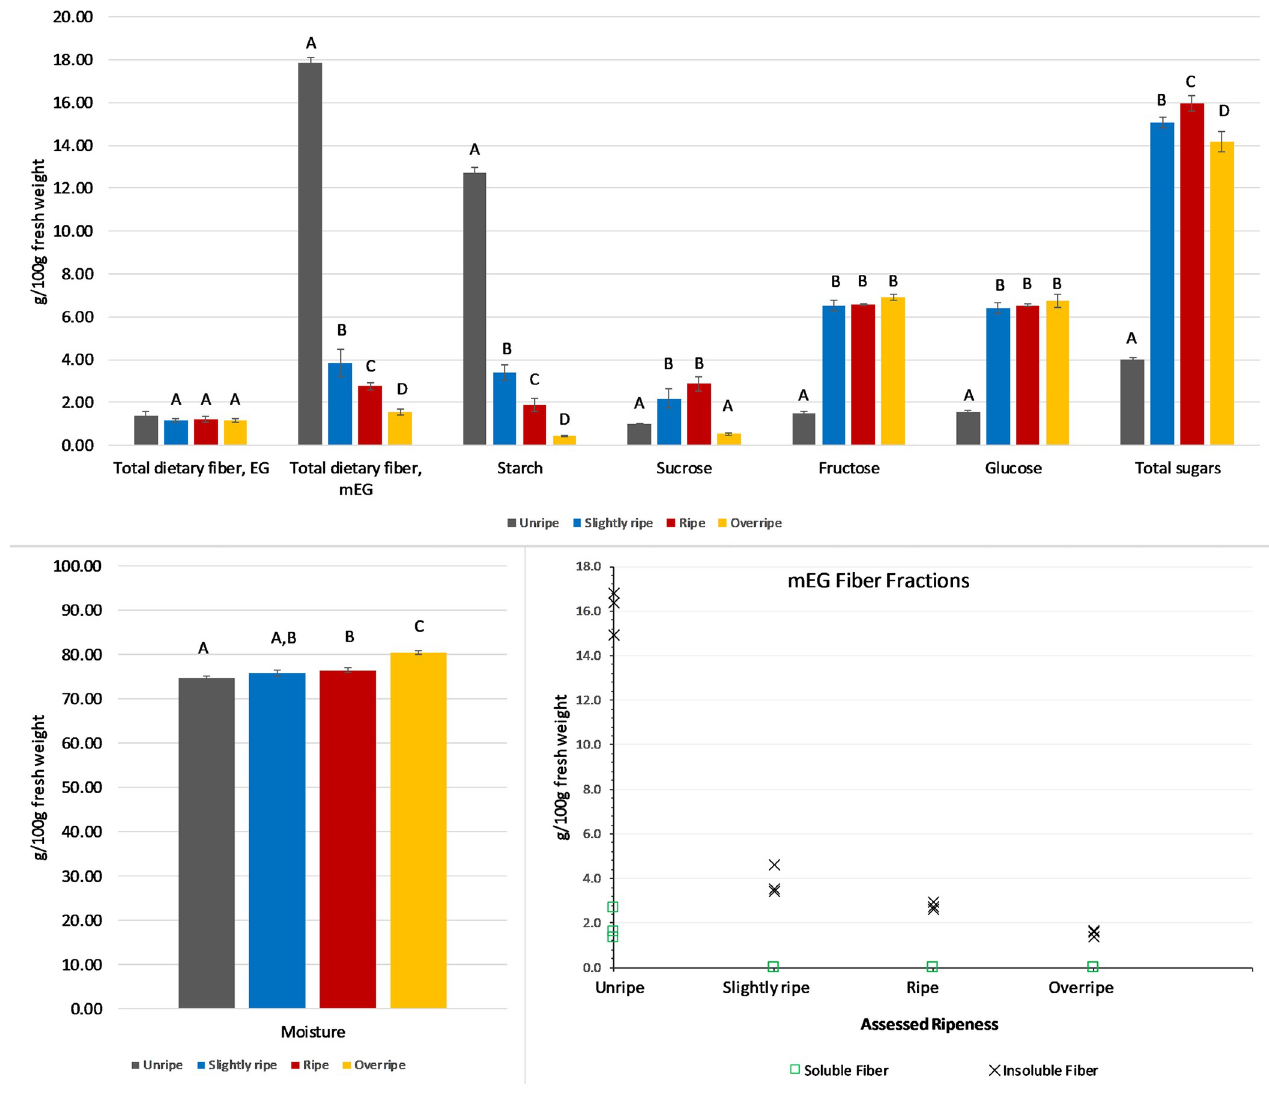
Fig 3. Changes in content of sugars, starch, and dietary fiber in a single lot of bananas assayed at different stages of ripeness. Values shown are the mean ± standard deviation for three samples of each ripeness, each consisting of a homogenate of three to five bananas, with ripeness assessed according to the criteria in Fig